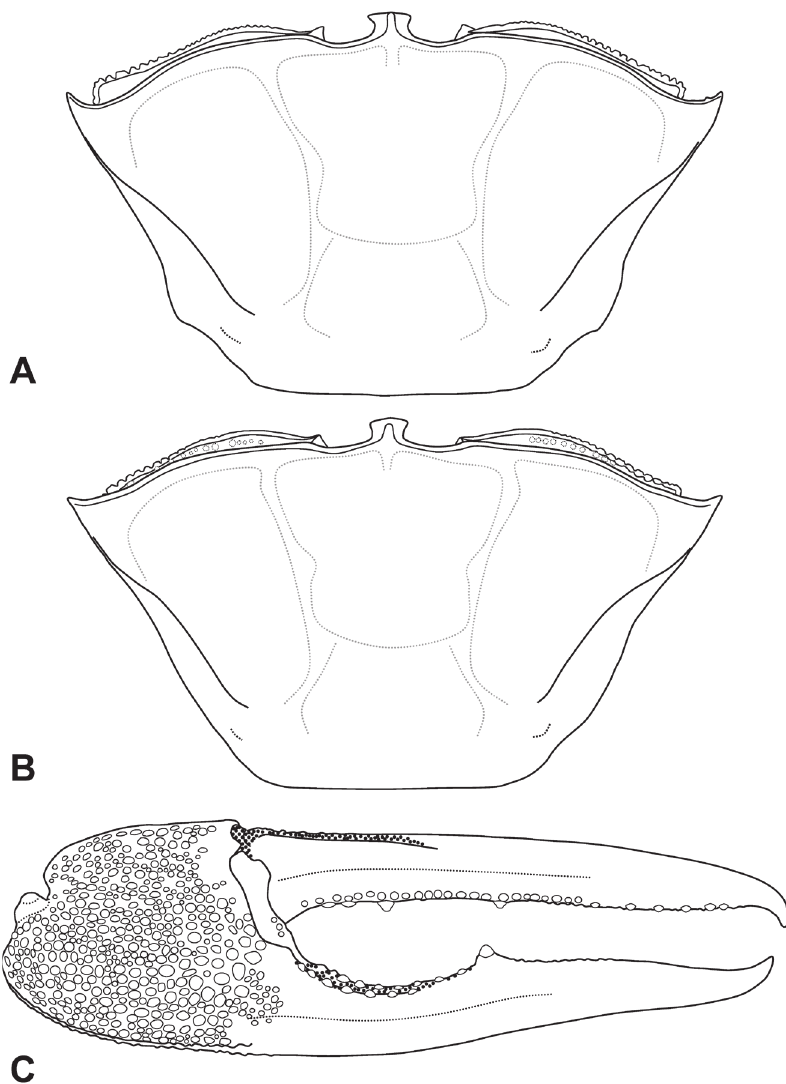
Figure 4. Tubuca alcocki sp. n. A, C holotype (CW 30.1 mm, PL 58.2 mm, ZRC 2017.1278; Thailand); T. urvillei (H. Milne Edwards, 1852) B male (CW 29.7 mm, ZRC 1999.1107; Mayotte). A, B dorsal view C major